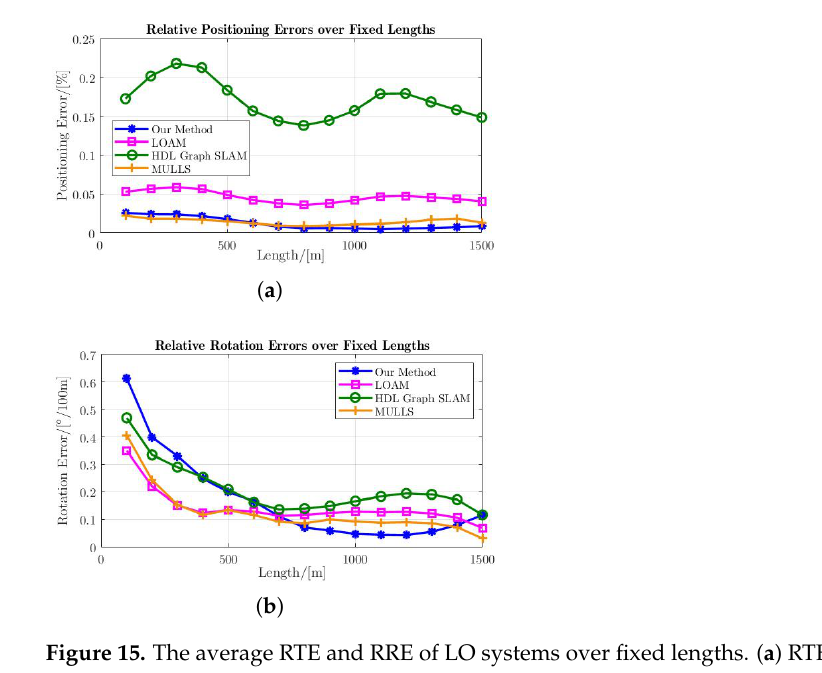
Figure 14. Cumulative distributions of absolute state errors and estimated trajectories. ( a ) Cumulative distributions of the absolute positioning errors; ( b ) Cumulative distributions of the absolute rotational errors; ( c ) Estimated trajectories. (InTEn-LOAM, LOAM, HDL-Graph-SLAM, groundtruth).